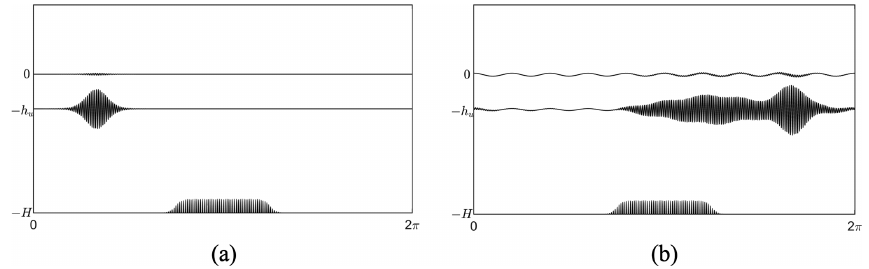
Figure 5. (a) Incident interfacial mode wave packet with k 1 H = 2 . 1 at t = 0. (b) The incident mode grows while simultaneously resonating with a surface mode with k 2 H = 0 . 1. Other relevant parameters are k b H = 2 . 0 ,U ∗ u = U ∗ = ω ∗ = 0 . 1095, N = 1024, M = 2, a ω ∗ 1 2 H = h u + h l .